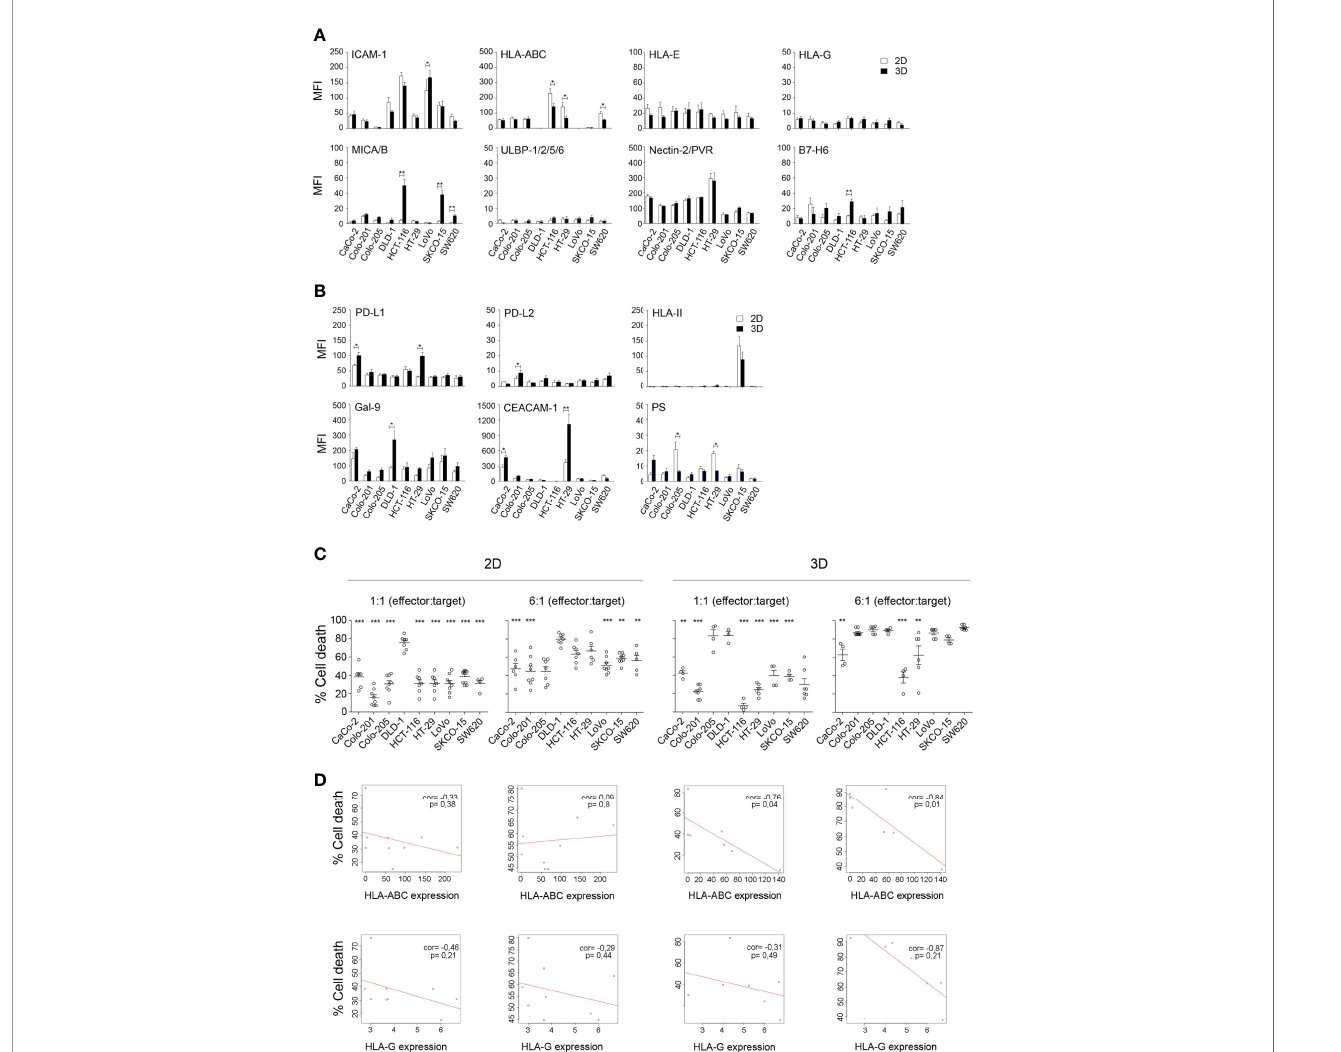
FIGURE 4 | Phenotypic characterisation of CRC cell lines and their correlation with sensitivity to activated NK cells. (A) Expression of ligands for conventional NK cell checkpoints in CRC cell lines cultured in 2D and 3D conditions. Data are presented as mean ± SEM of at least 4 experiments. Statistical analyses were performed by t-test. ∗ p < 0.05; ∗∗ p < 0.01. (B) Expression of ligands for emerging NK cell checkpoints in CRC cell lines cultured in 2D and 3D conditions. Data are presented as mean ± SEM of at least 4 experiments. Statistical analyses were performed by t-test. ∗ p < 0.05; ∗∗ p < 0.01. (C) Cytotoxicity of activated NK cells against a panel of CRC cell lines in both 2D and 3D conditions. Cell death of CRC cells was analysed after 4 h co-culture (2D) or 48 h co-culture (3D) with activated NK cells, at low (3:1) and high (6:1) e:t ratios, by fl ow cytometry using Annexin-V/PS staining in the e-Fluor670-negative population. Data are presented as mean ± SEM from at least 4 donors after subtraction of respective controls without effector NK cells. Cell viability without NK cells was always >85%. Statistical analyses were performed by one-way ANOVA test with Dunnett ’ s multiple-comparison post-test. ∗∗ p < 0.01; ∗∗∗ p < 0.001. (D) Correlation between HLA-ABC or HLA-G expression and cell death induced by activated NK cells in CRC cell lines. A simple regression model was then fi tted with ligand expression level and percentage of cell death for both low and high e:t ratios and 2D and 3D cultures. Plots represent ligands with a signi fi cant p -value. ∗ p < 0.05. CRC, colorectal